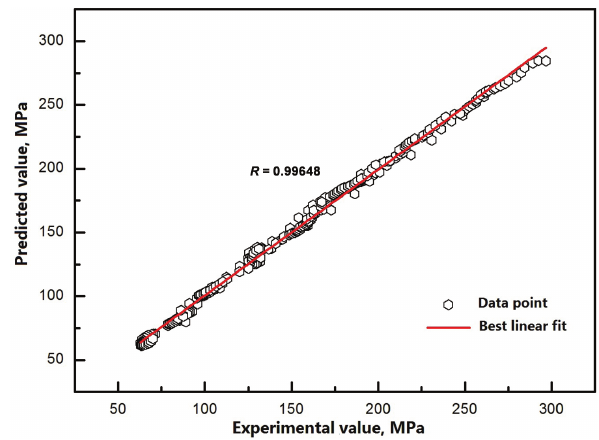
Figure 9: Correlation between predicted and experimental values under different experimental condition.